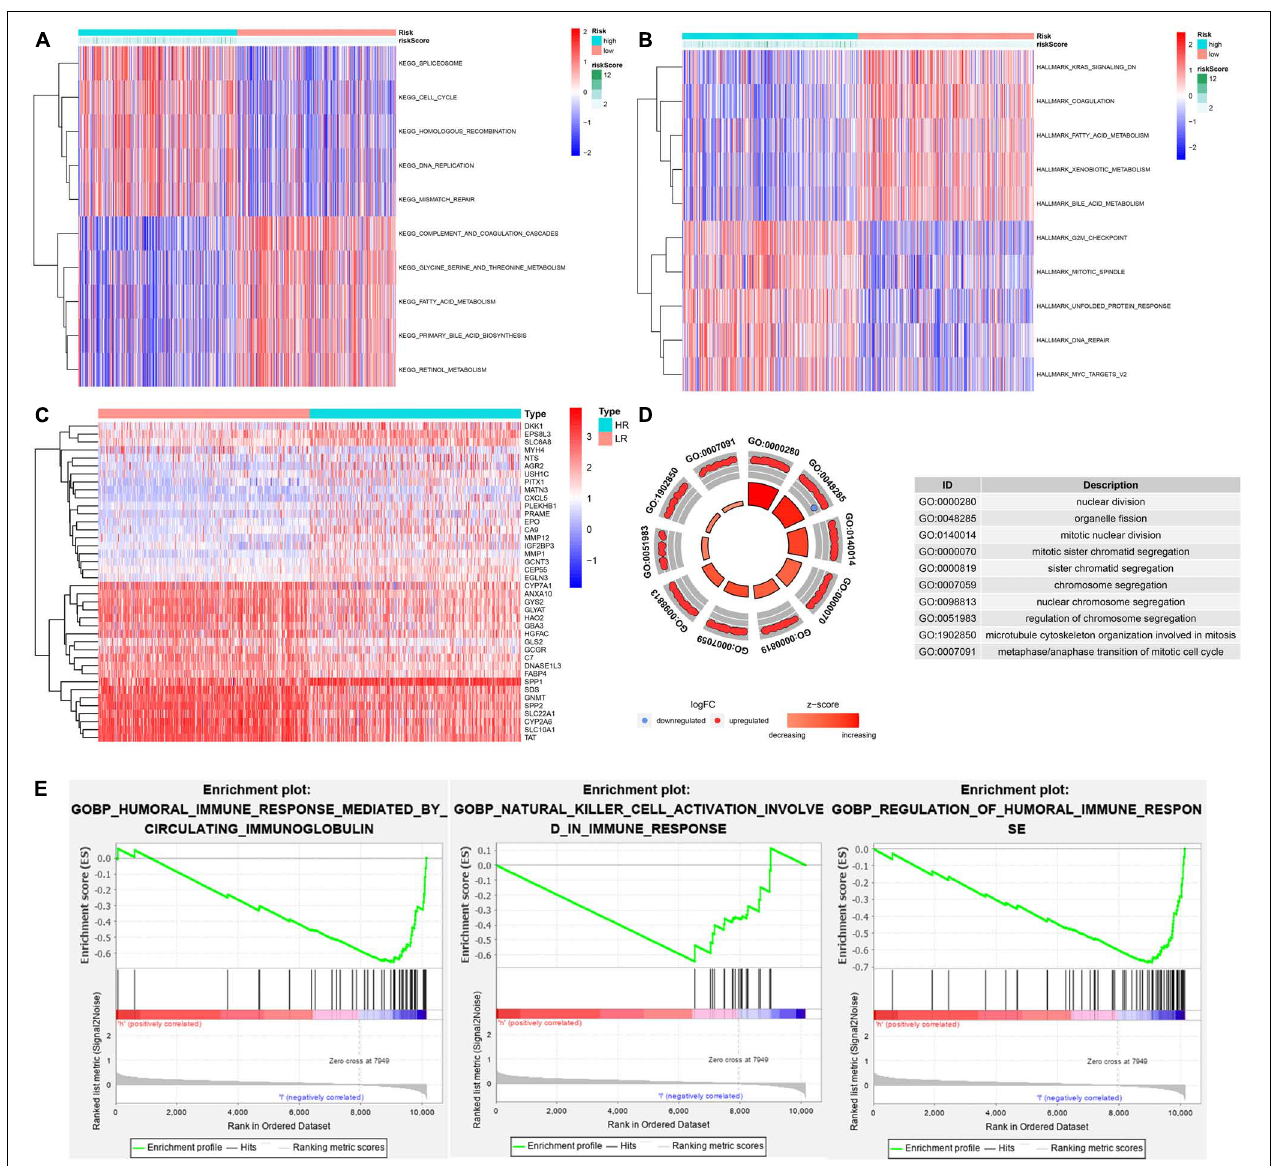
FIGURE 10 | The potential molecular mechanism of the prognostic signature. (A) GSVA-KEGG. (B) GSVA-HALLMARK. (C) The heatmap of DEGs between high- and low-risk groups. (D) GO function annotation of DEGs. (E) GSEA using immune gene